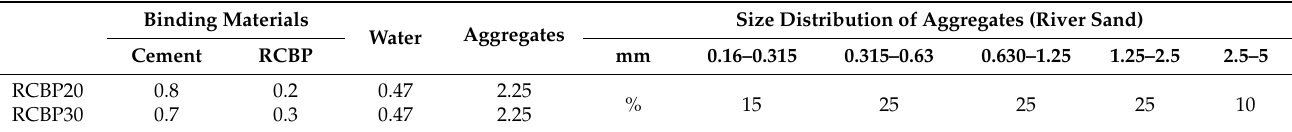
Table 6. Mix. proportion of mortars used to determine the inhibiting effect of RCBP on ASR.